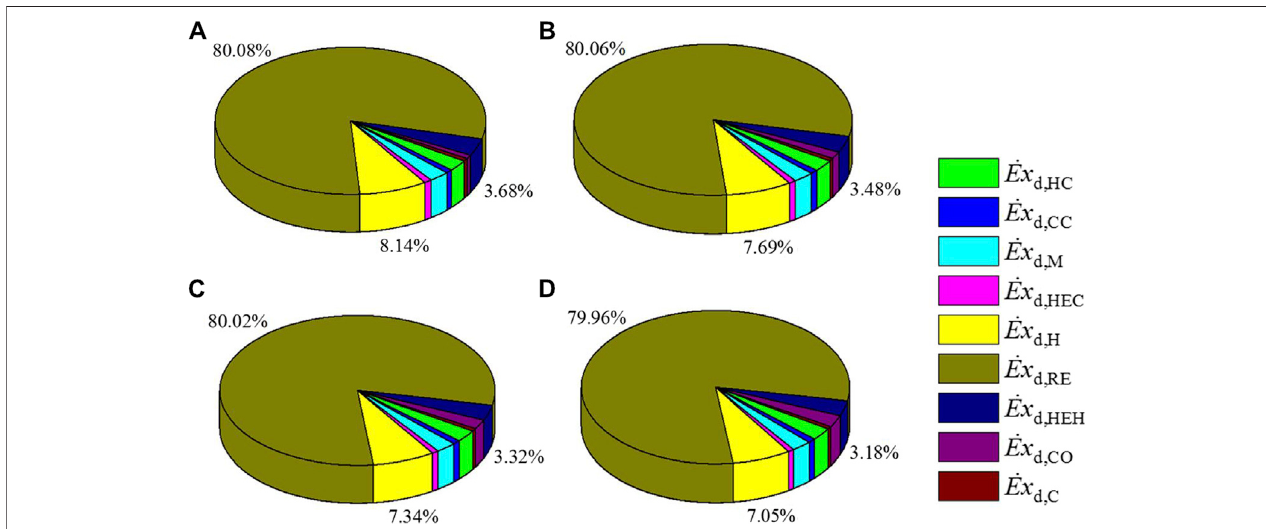
FIGURE 3 | Distribution proportion of exergy destruction for each component under different reaction pressures, (A) 5 MPa, (B) 6 MPa, (C) 7 MPa, (D) 8 MPa.